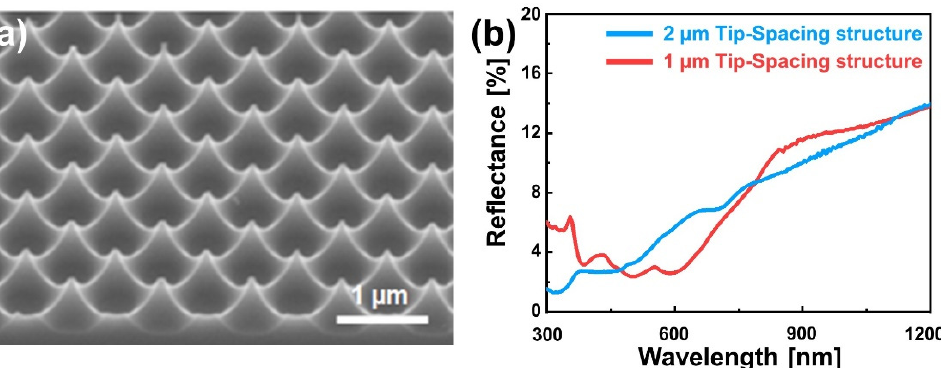
Figure 6. ( a ) Silicon microstructure with a 1- μ m tip spacing. ( b ) The reflectance spectra following the density of the microstructure.